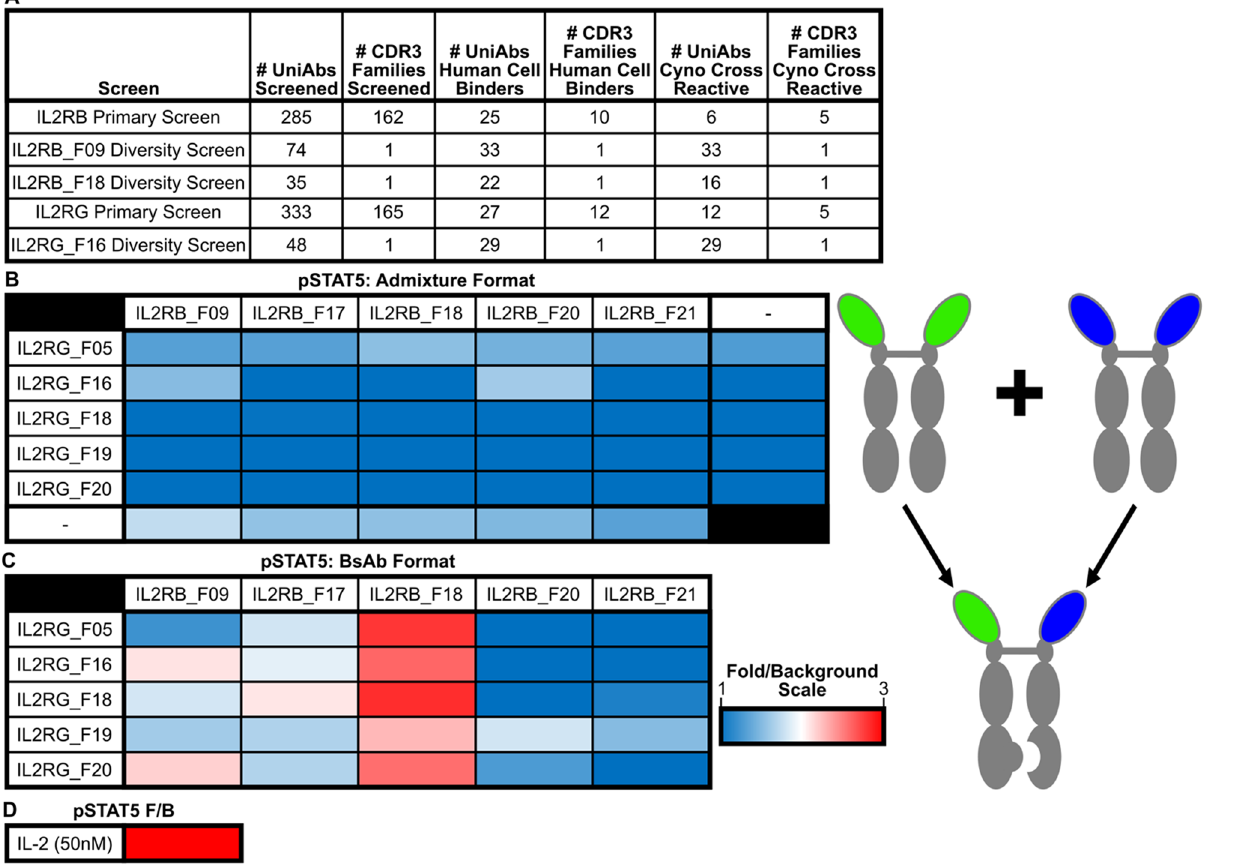
Figure 1. Bispecific antibodies specific to IL-2Rβ and IL-2Rγ induce phosphorylation of STAT5. ( A ) Summary of IL-2RB and IL-2RG monospecific UniAb binders identified during antibody lead discovery. ( B , C , D ) Heatmaps showing fold-induction of phosphorylated STAT5 (pSTAT5) in CD8 + T-cells from human PBMCs treated with individual monospecific UniAbs or αIL2Rβ and αIL2Rγ monospecific UniAbs in a 1:1 molar ratio mixture ( B ), αIL-2Rβ/γ bispecific UniAbs ( C ), or rhIL-2 positive control ( D ) at 50 nM for 1 h. In the antibody graphic on the right, the green and blue arms represent IL2RG and IL2RB binding domains, respectively. pSTAT5 levels were determined by flow cytometry and reported as geometric mean fluorescent intensity (gMFI) over the gMFI of unstimulated